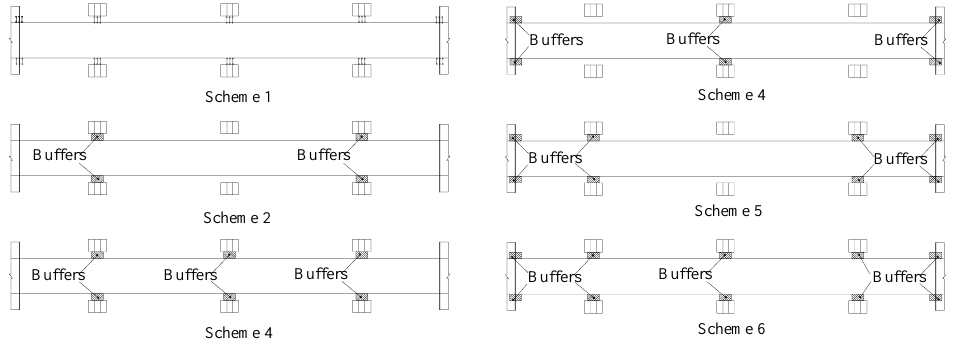
Figure 4. Six different layout schemes of the buffers.